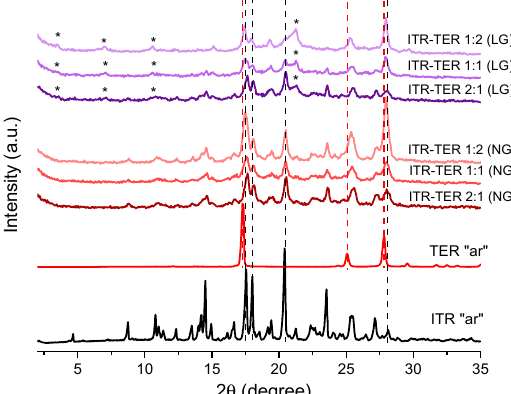
Figure 2. Powder X-ray diffraction (PXRD) of the ITR and TER starting material as the received powders (“ar”) and binary ITR and TER mixtures following neat grinding (NG) and liquid-assisted grinding (LG). * Indicates the distinct peak of the new phase (cocrystal), broken black lines show the position of the ITR diffraction peaks, while the broken red lines show the position of the TER diffraction peaks.